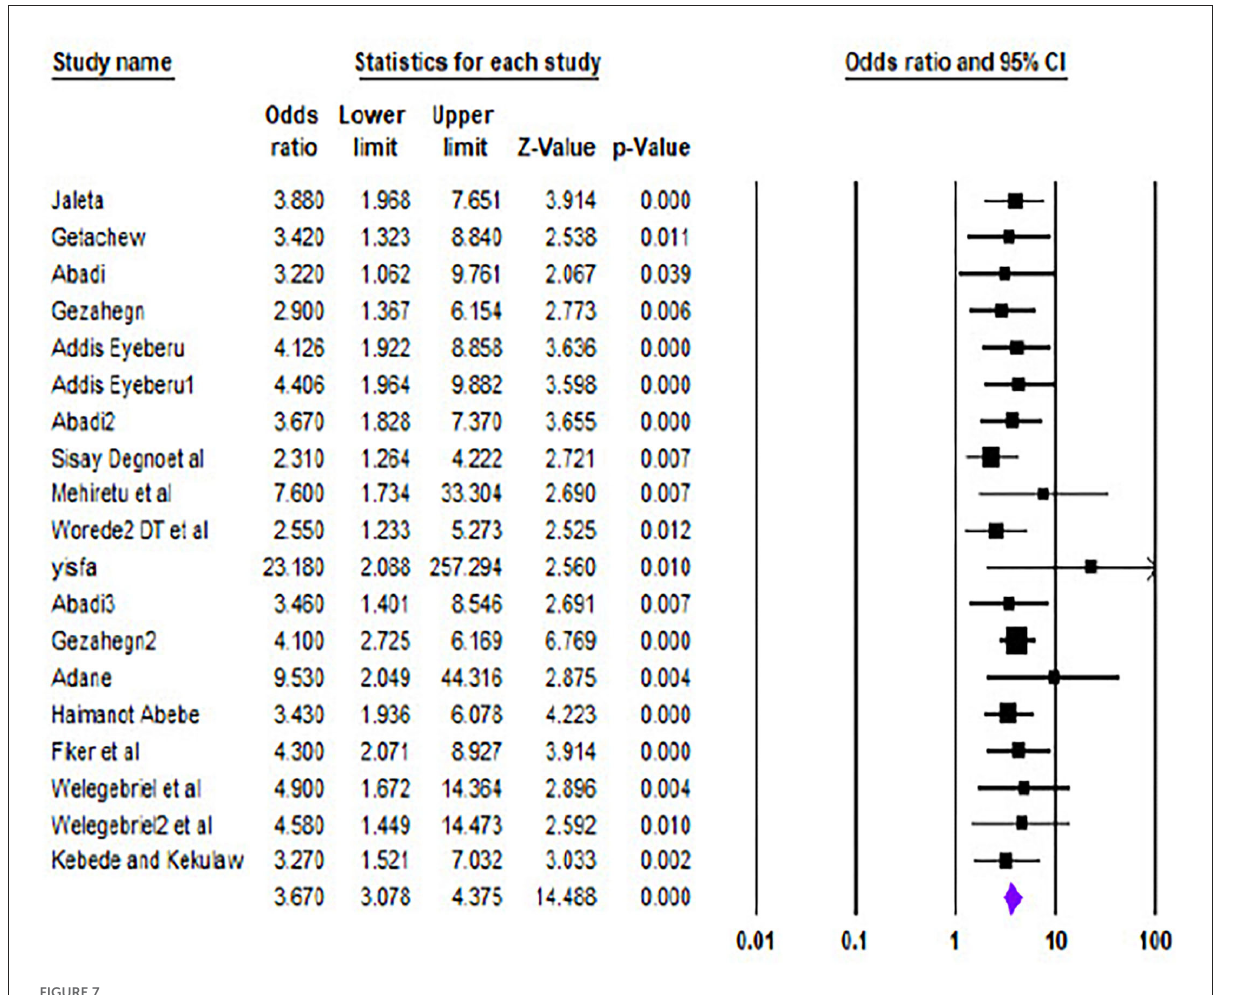
FIGURE7 Obstetrics emergency and adverse maternal